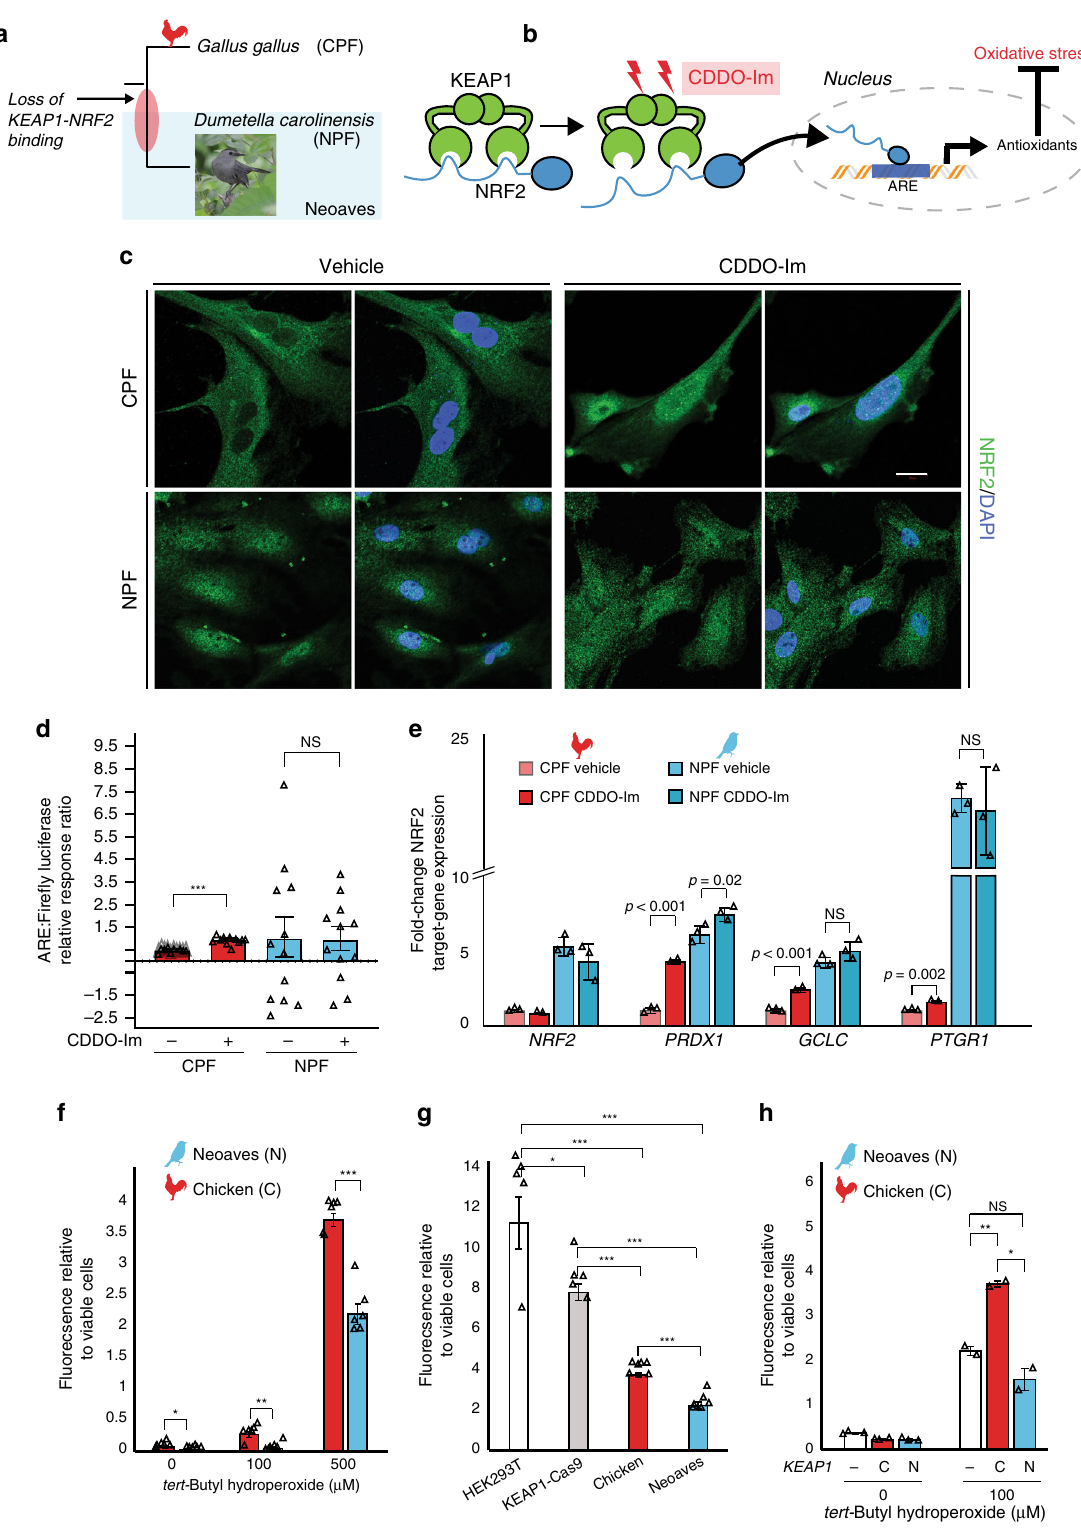
displayed a strongly inducible nuclear localization response to CDDO-Im treatment (Fig. 3c). In striking contrast, Neoaves cells displayed strong constitutive NRF2 nuclear localization (Fig. 3c, vehicle), and there was no increase in NRF2 nuclear localization in Neoaves cells treated with CDDO-Im (Fig. 3c, CDDO-Im, bottom row). These results are consistent with the loss of KEAP1- mediated regulation of NRF2 in